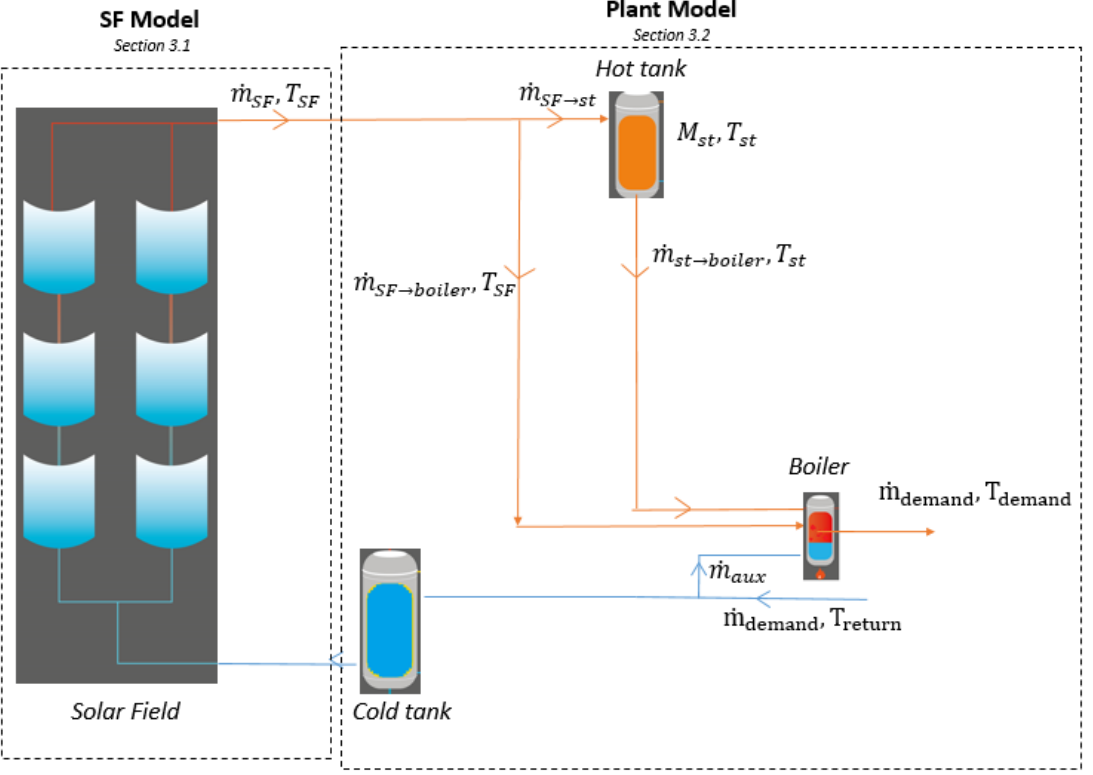
Figure 1. Schematic of the system of interest and control variables .